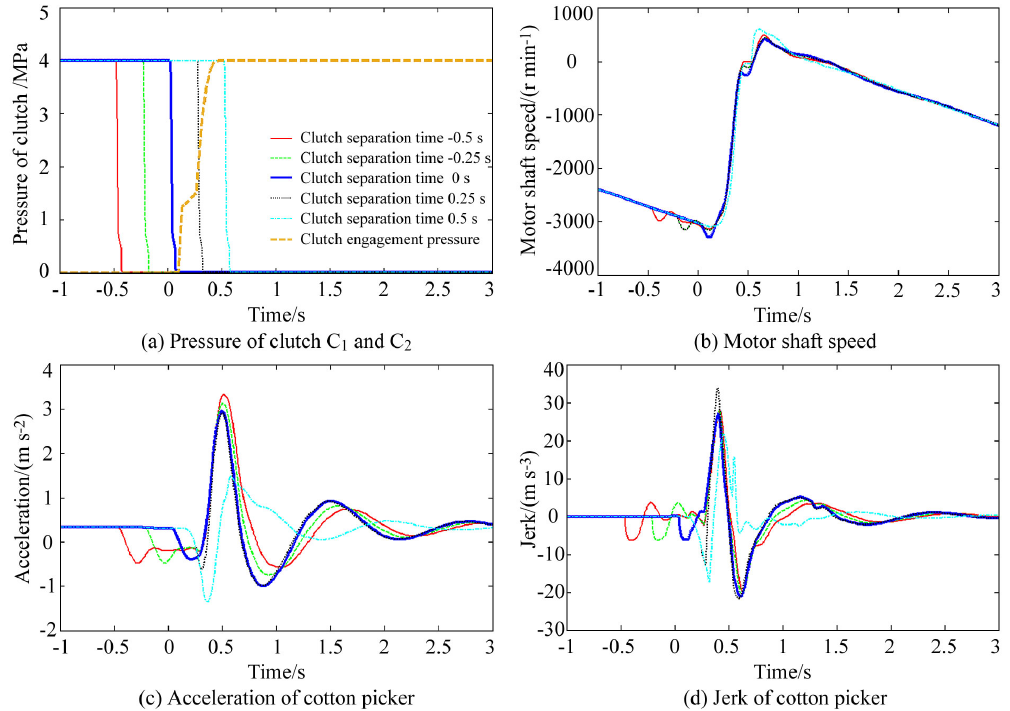
Figure 8. Influence of clutch separation time on the shift quality of the cotton